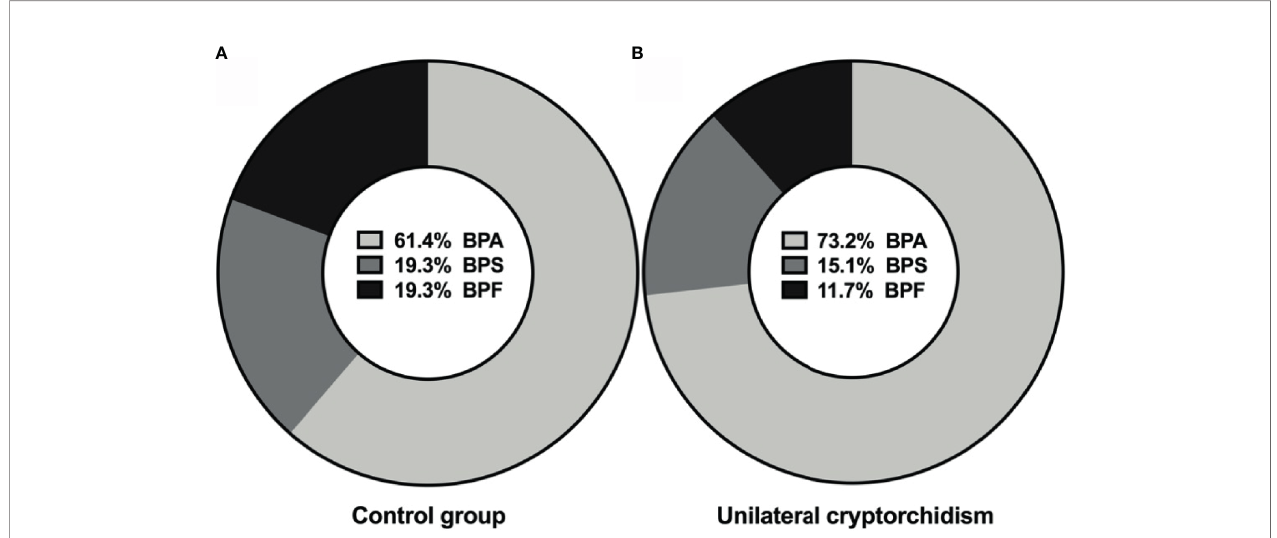
FIGURE 1 | Percentage distributions of bisphenols in plasma of control group (A) , and unilateral cryptorchidism (B)